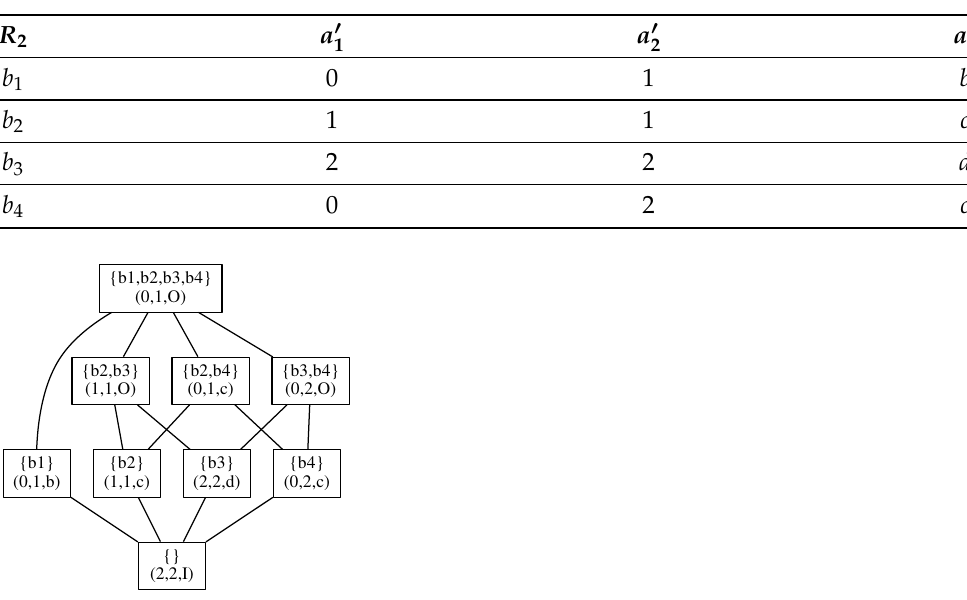
Table 2. Incidence relation R 2 .